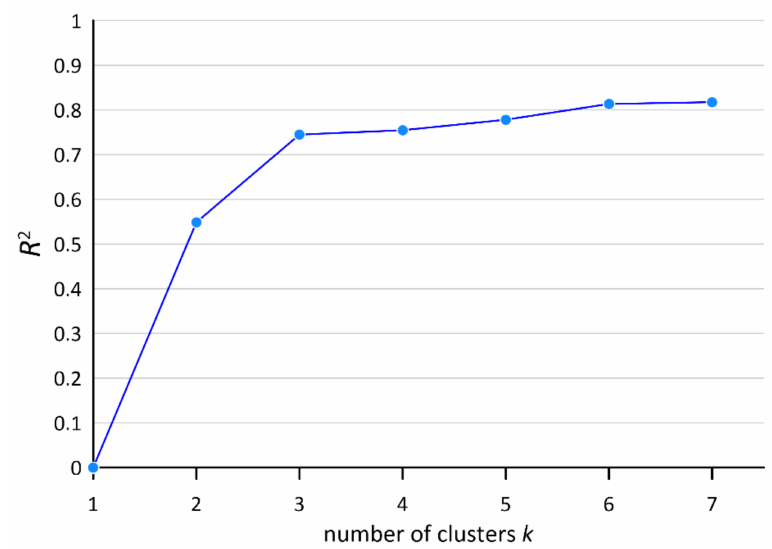
Figure 4. Graph of the variation of R 2 as a function of the number of clusters k